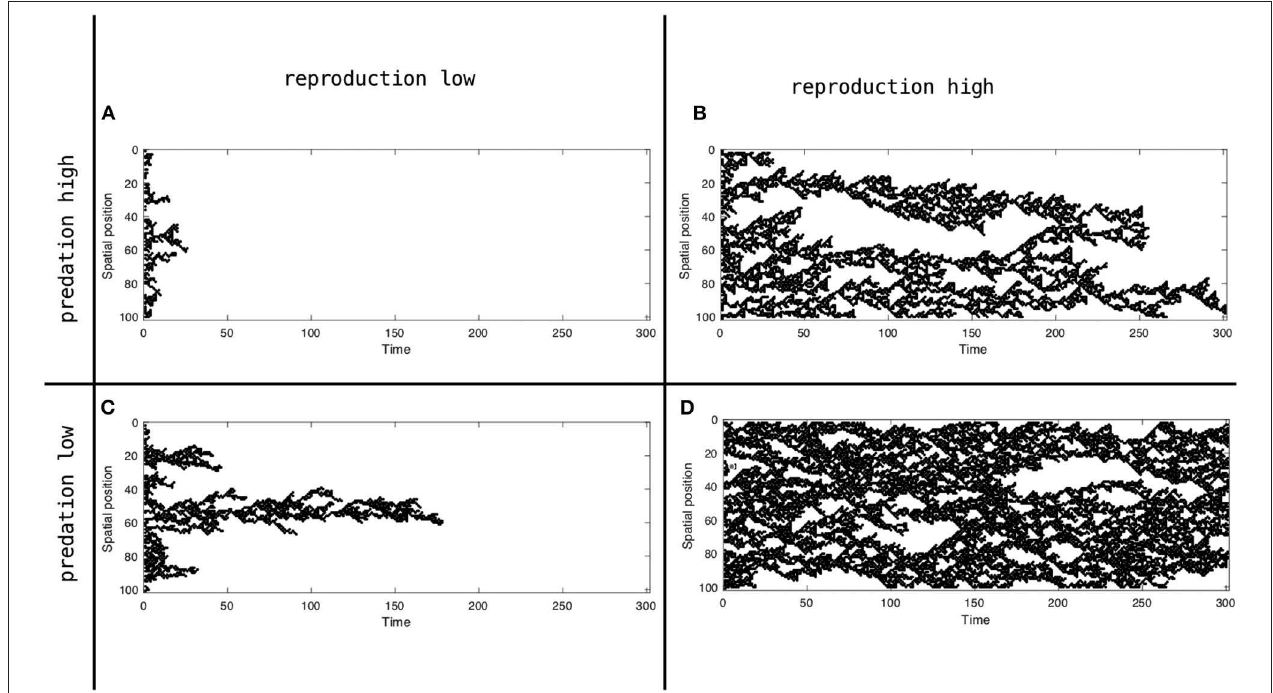
FIGURE 3 | Spatial position (y axis) over time (x axis) realization of the model represented by system 4, for two migration (p) and two predation (q) probabilities (p 0.5, q 0, 0.5). (A) With reproduction low and predation high. (B) With reproduction high and predation high. (C) With reproduction low and predation high. (D) With = reproduction high and predation